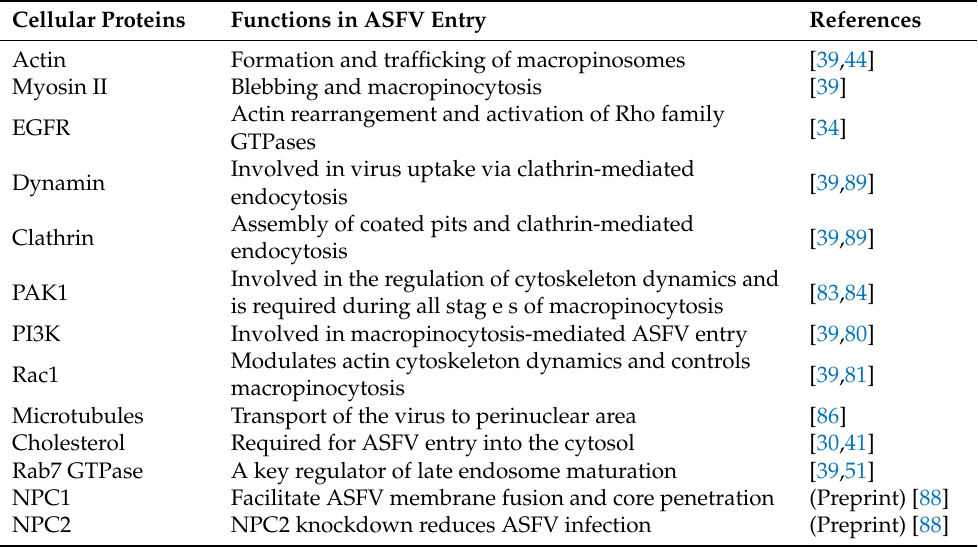
Table 2. The cellular factors involved in ASFV